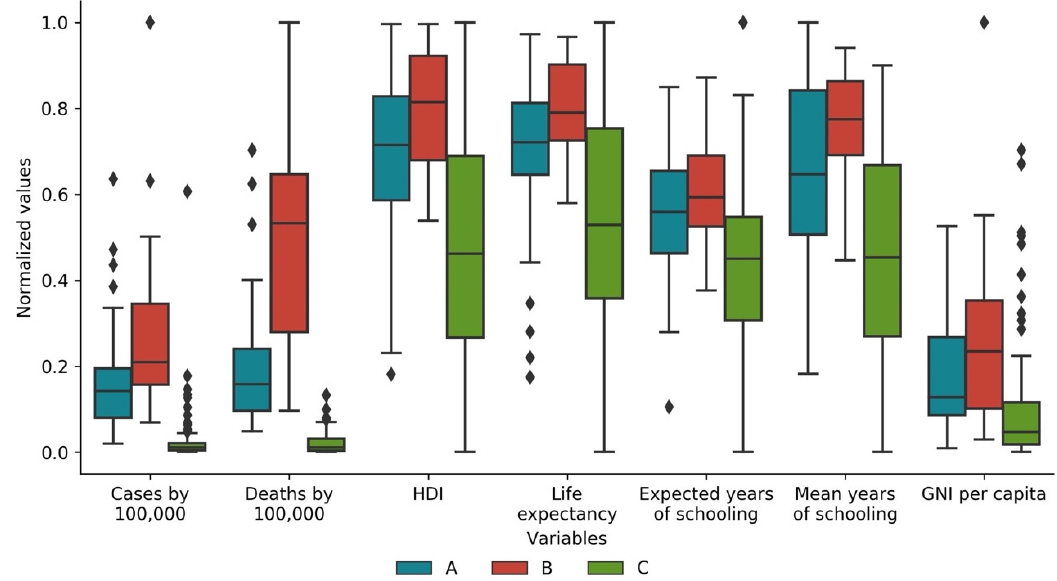
Figure 18. Boxplots of variables per cluster of deaths at Day 250 (excluding the 24 countries/territories that are not present in the UNDP dataset) (HDI, Human Development Index; GNI, Gross National Income).